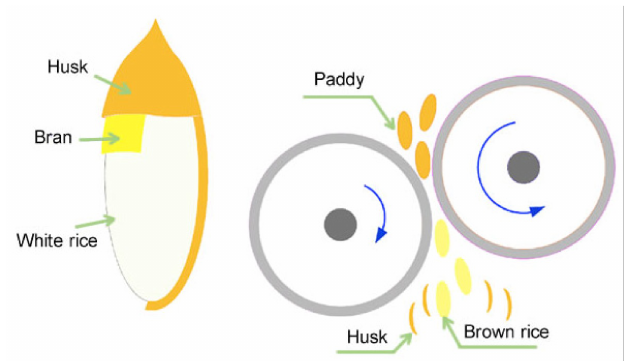
Figure 1. Final products of paddy grain after husking